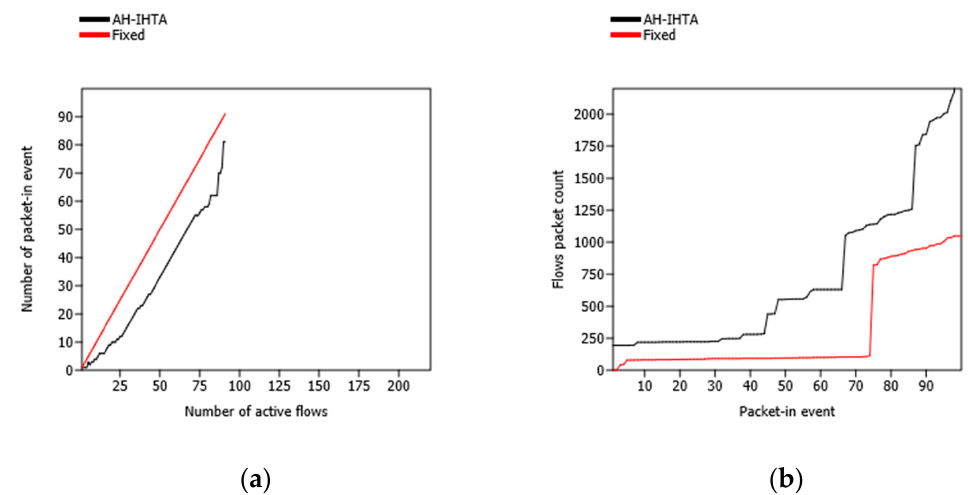
Figure 7. Results of idle and hard timeout with fixed flow table size. ( a ) Number of packet-in event with respect to number of active flows. ( b ) Flows packet count with respect to packet-in